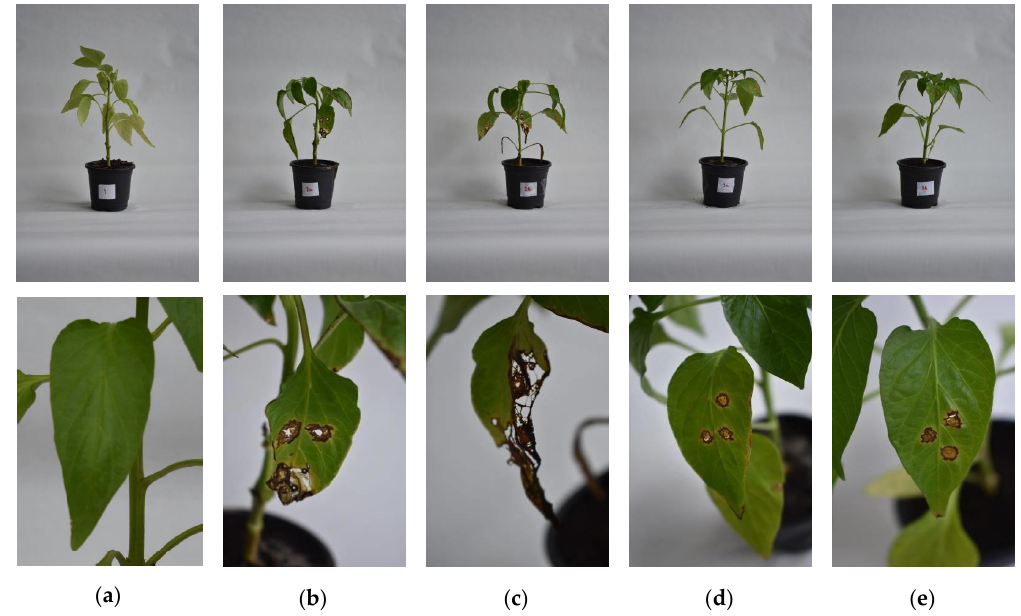
Figure 9. The results of in planta testing of the produced biocontrol agents based on B. velezensis IP22 against X. euvesicatoria : ( a ) uninoculated and untreated control (negative control—plant 1), ( b ) untreated control inoculated with X. euvesicatoria PL 1 (positive control—plant 2A), ( c ) untreated control inoculated with X. euvesicatoria PL 2 (positive control—plant 2B), ( d ) plant treated with B. velezensis cultivation broth and inoculated with X. euvesicatoria PL 1 (plant 3A), ( e ) plant treated with B. velezensis cultivation broth and inoculated with X. euvesicatoria PL 2 (plant 3B).